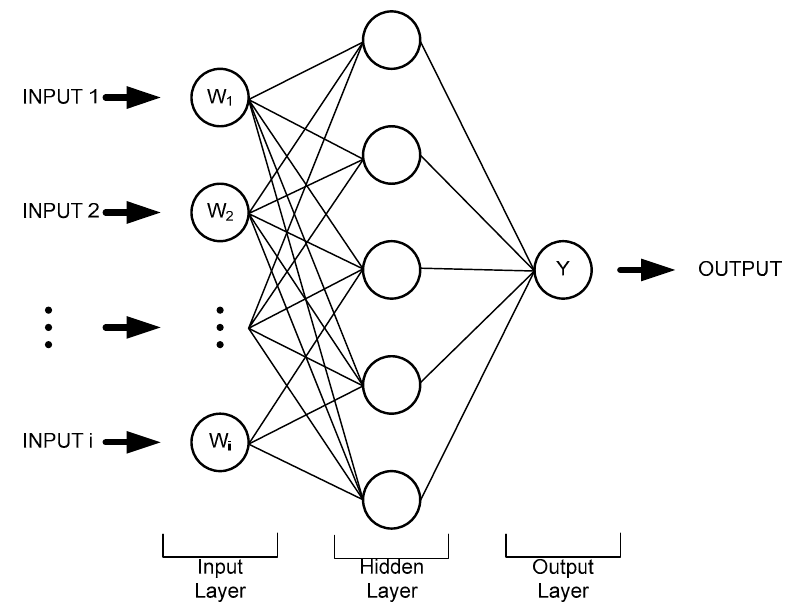
Figure 4. Structure of an Artificial Neural Network.